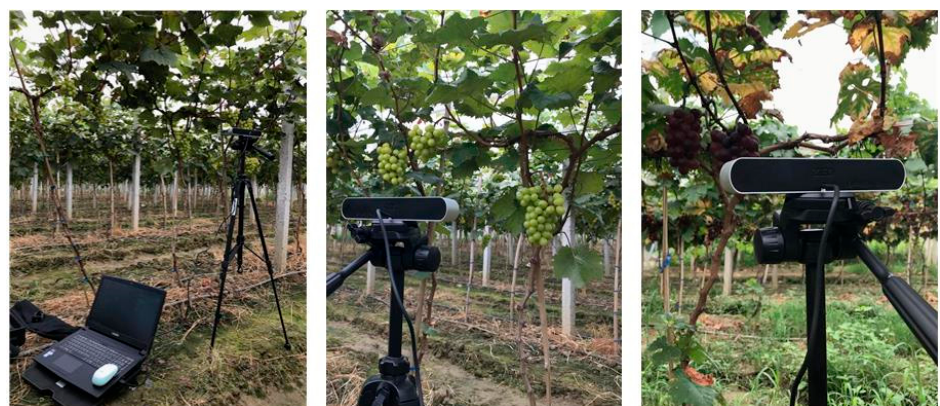
Figure 2. Shooting environment and equipment image.